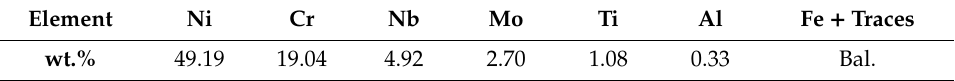
Table 1. Nominal chemical composition of gas atomized IN718 powder. Element Ni Cr Nb Mo Ti Al Fe + Traces wt.% 49.19 19.04